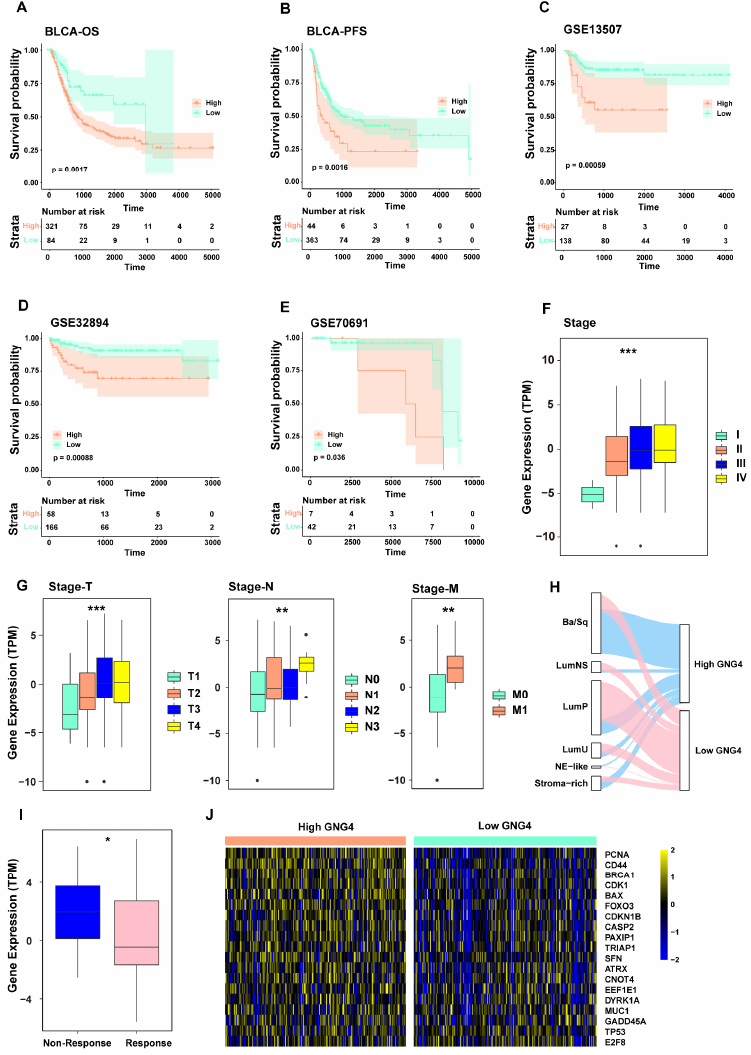
Figure 4. GNG4 as a biomarker to predict survival and chemotherapy effectiveness. ( A ).